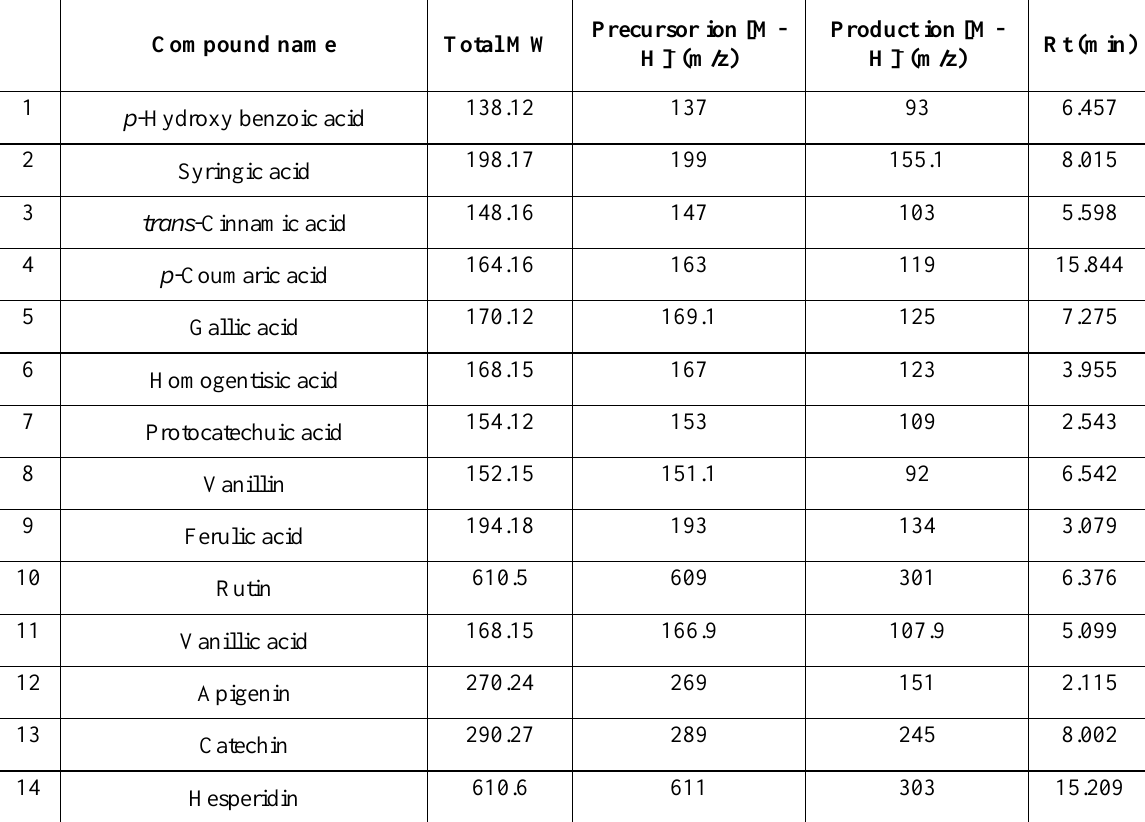
Table 3.Phenolic compounds that are founded in ethanolic 70% extract of T.claveryi (starting by the most